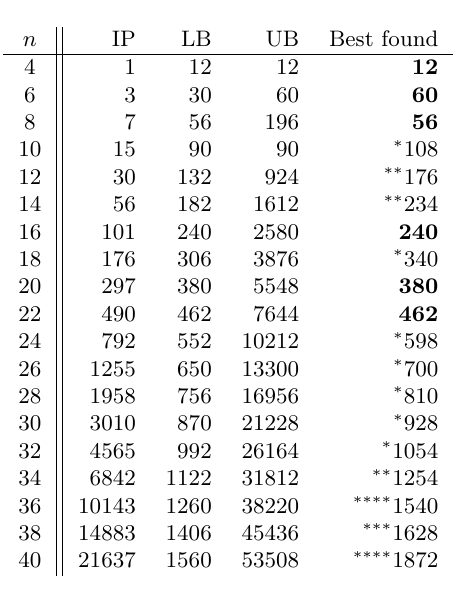
Table 8: Results obtained for round-robin tournaments of orders 4 that attain the lower bound are shown in boldface, while ∗ indicates that the COE-value attains the second best possible solution value (using starters), ∗∗ indicates that the starter attains the third best possible solution value, etc . The number of integer partitions of n of possible COE-values of round-robin tournaments of order n constructed from starters) are also given, together with the lower bound n ( n